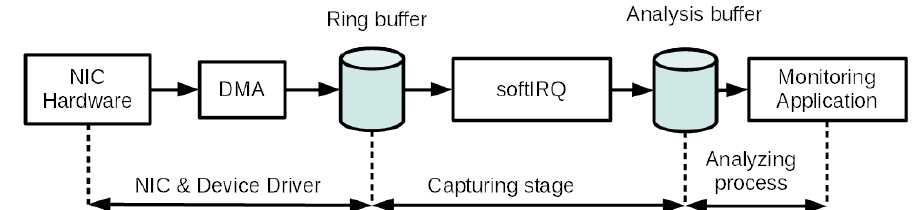
Figure 1. Packet receiving process with Linux networking